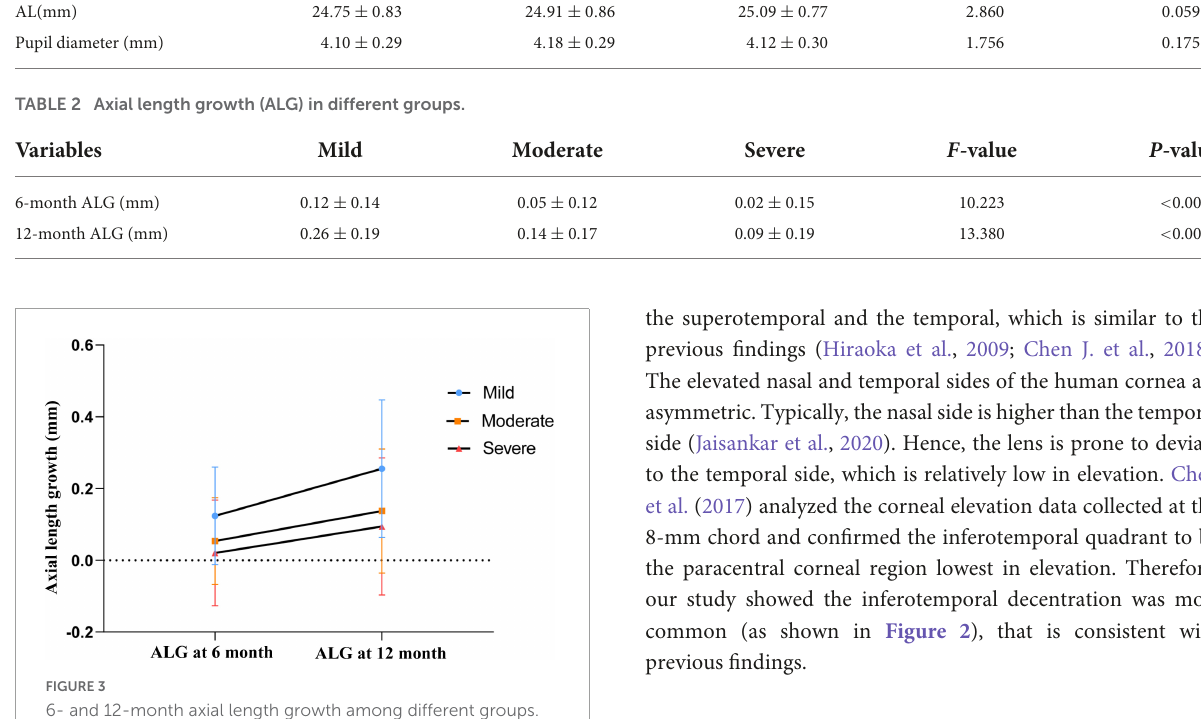
FIGURE3 6- and 12-month axial length growth among different groups. The mean values are represented by blue dots (mild decentration group), orange squares (moderate decentration group) and red triangles (severe decentration group), respectively. Error bars represent standard deviation of the